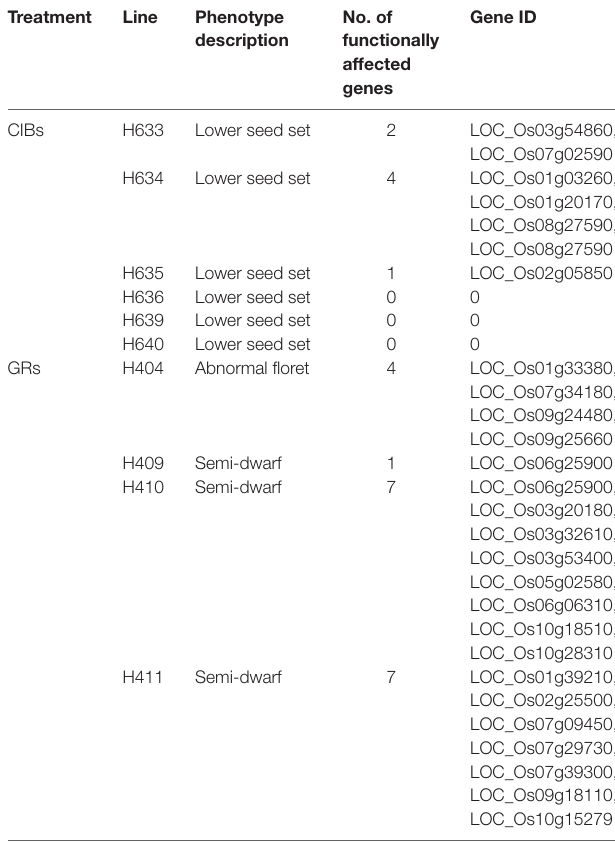
TaBLe 5 | Functionally affected genes in each mutant.